Question: Write a caption explaining this figure to a reader.
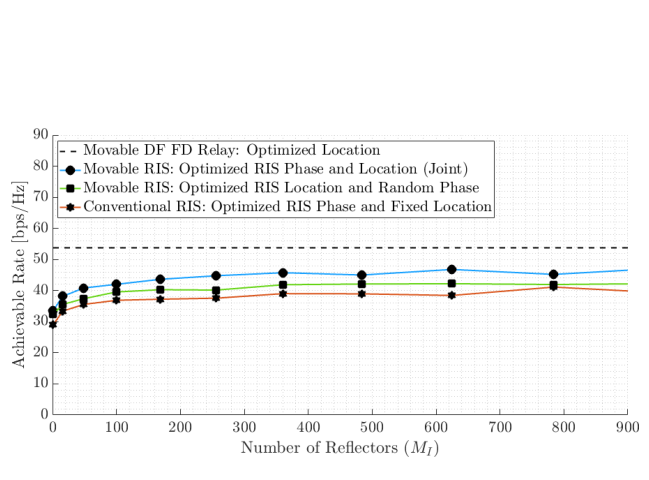
Answer: Achievable rate comparison of different phase adjustment methods in RIS-aided AB-HPC systems for varying MI.